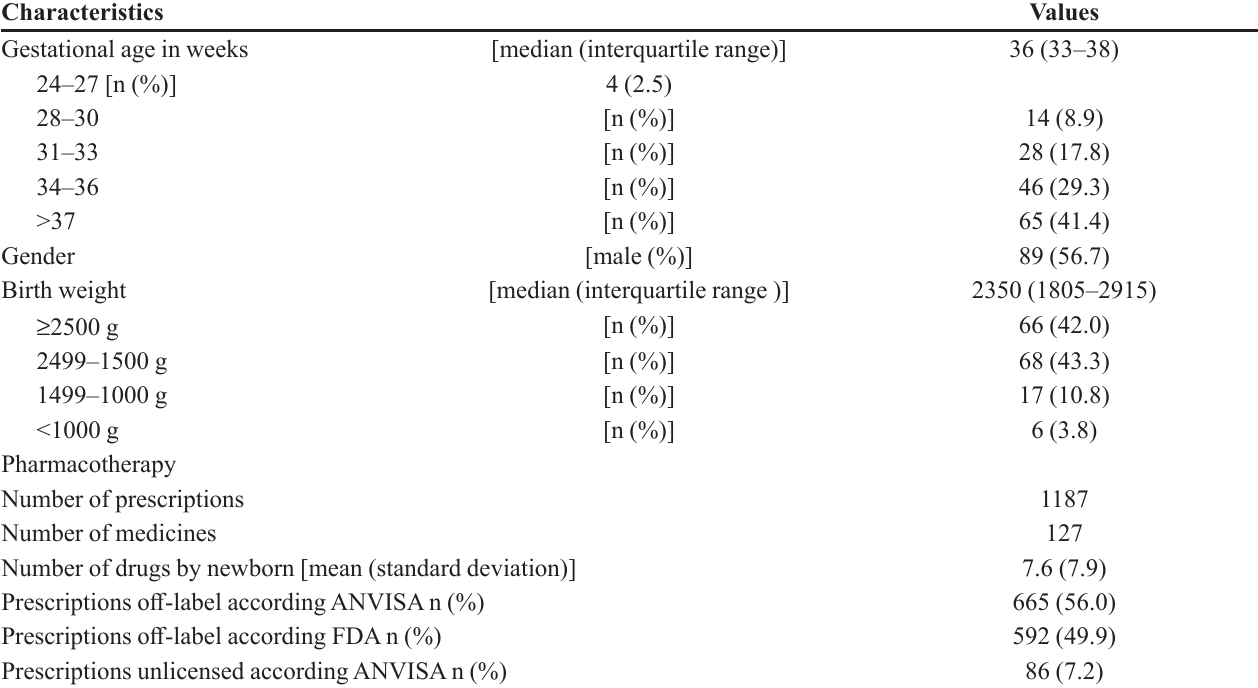
TABLE I - Perinatal, demographic, clinical, and pharmacotherapeutic characteristics of the 157 neonates